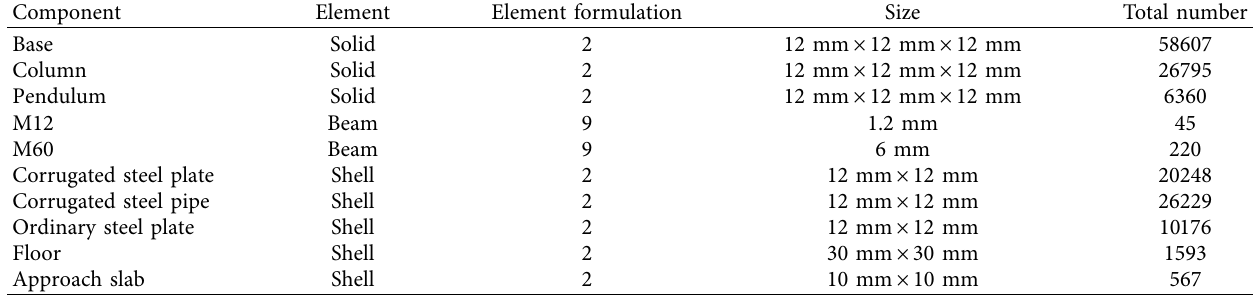
Table 1: Composition of the finite element model.